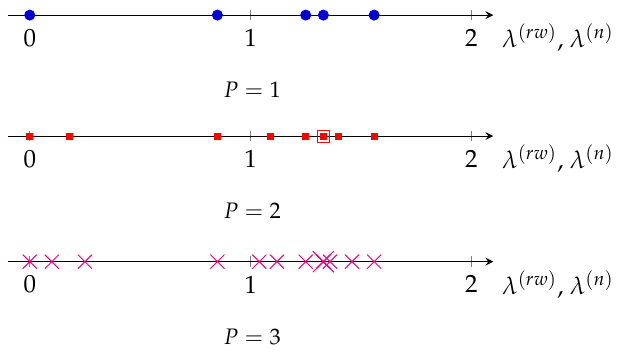
Figure 7. Eigenvalues of L